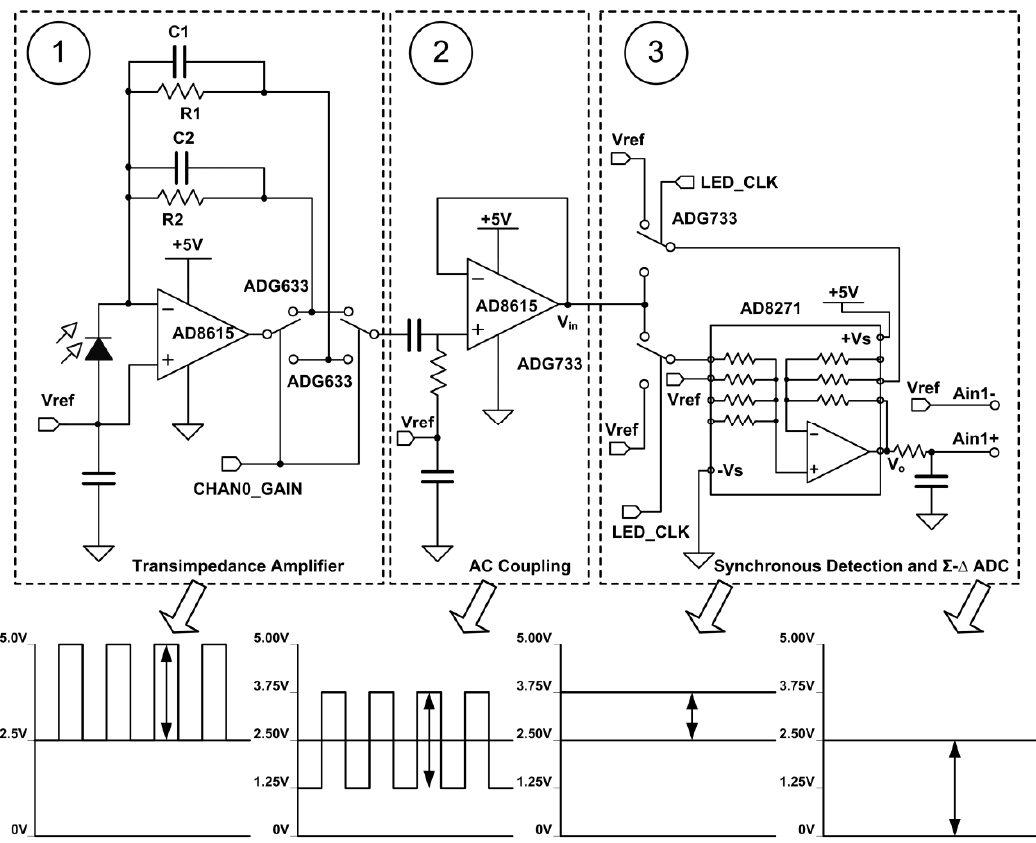
Figure 5. Signal conditioning circuit diagram and time-domain waveforms at each step. CHAN0_GAIN, channel 0 gain control signal; LED_CLK, LED pulse control signal; V in , ADG733 input signal; V o , AD8271 output signal; Ain1-, Ain1+, differential input